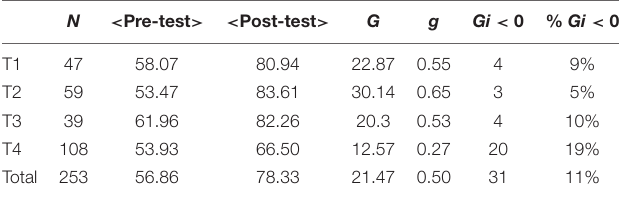
TABLE 1 | Learning gain in the first activity.